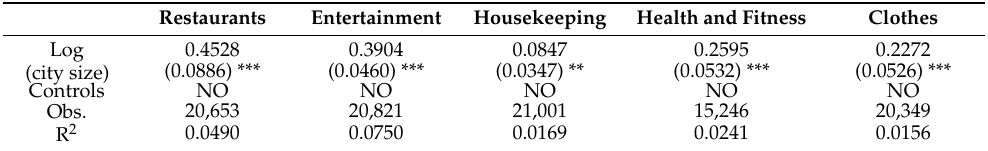
Table 2. The effect of city size on household expenditures; bivariate